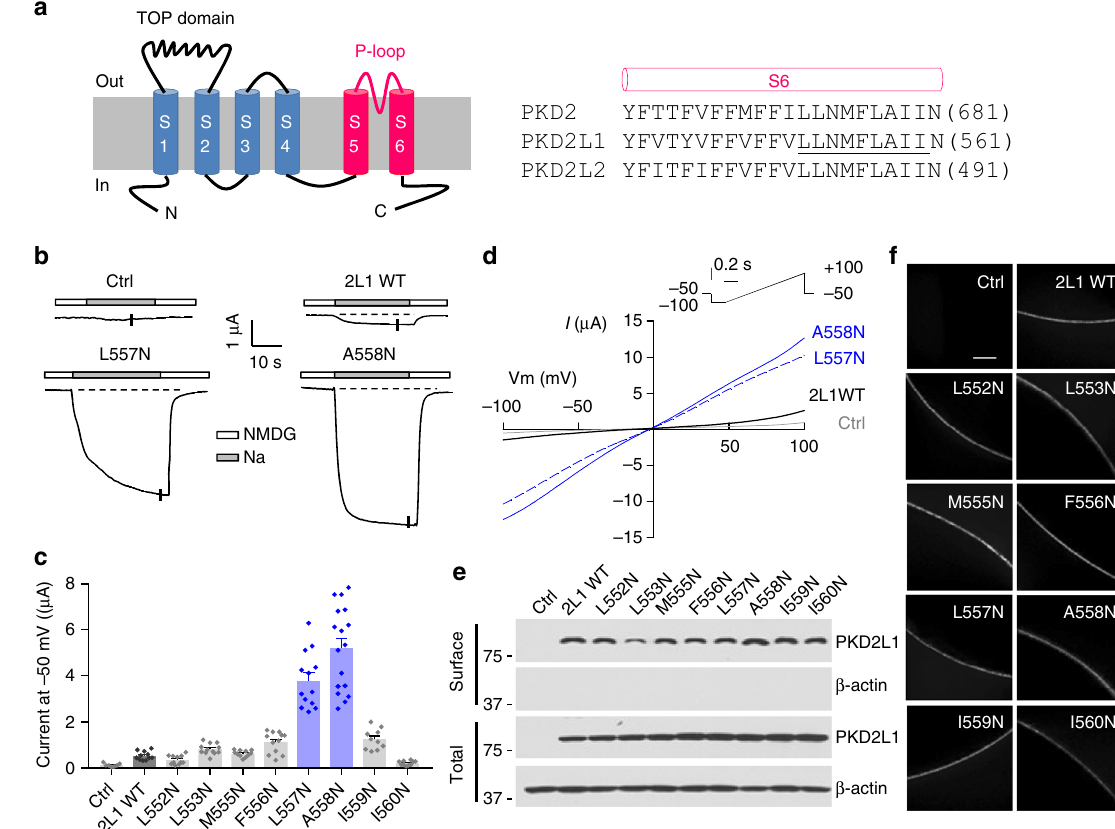
Fig. 1 Identi fi cation of PKD2L1 hydrophobic gate in the S6 helix. a Left panel, membrane topology of polycystin channels. The TOP domain between S1 and S2 and the P-loop between S5 and S6 are indicated. Right panel, amino acid (aa) sequence alignment of S6 helix of human PKD2, PKD2L1 and PKD2L2. Each single underlined aa of PKD2L1 was mutated to asparagines (N). b Representative current traces obtained from oocytes injected with WT or a mutant (L557N or A558N) PKD2L1 cRNA, or water (Ctrl). Oocytes were voltage clamped at -50 mV in the presence of the extracellular solution containing (in mM) 100 N -methyl- D -glucamine (NMDG)-Cl, 2 KCl, 1 MgCl 2 , 10 HEPES at pH 7.5 ( “ NMDG ” ), or Na-containing solution (equimolar Na + substituting NMDG) ( “ Na ” ). Dashed lines are the baselines from which plateau current values were determined. c Averaged currents as the difference between NMDG- and Na-containing solutions obtained at − 50 mV, as in b , in oocytes expressing the single mutants, as indicated. For each mutant, currents were averaged from 10 to 17 oocytes from three batches. Data are presented as mean ± SEM. d Representative I – V curves from Ctrl (water-injected oocytes), PKD2L1 WT, L557N or A558N expressing oocytes obtained at current points indicated by the vertical bars in the traces in b , using the indicated voltage ramp protocol. e Western blot of surface biotinylated and total PKD2L1 WT or indicated mutants. f Whole-mount immuno fl uorescence showing the oocyte surface expression of PKD2L1 WT or mutants from e . Scale bar, 50